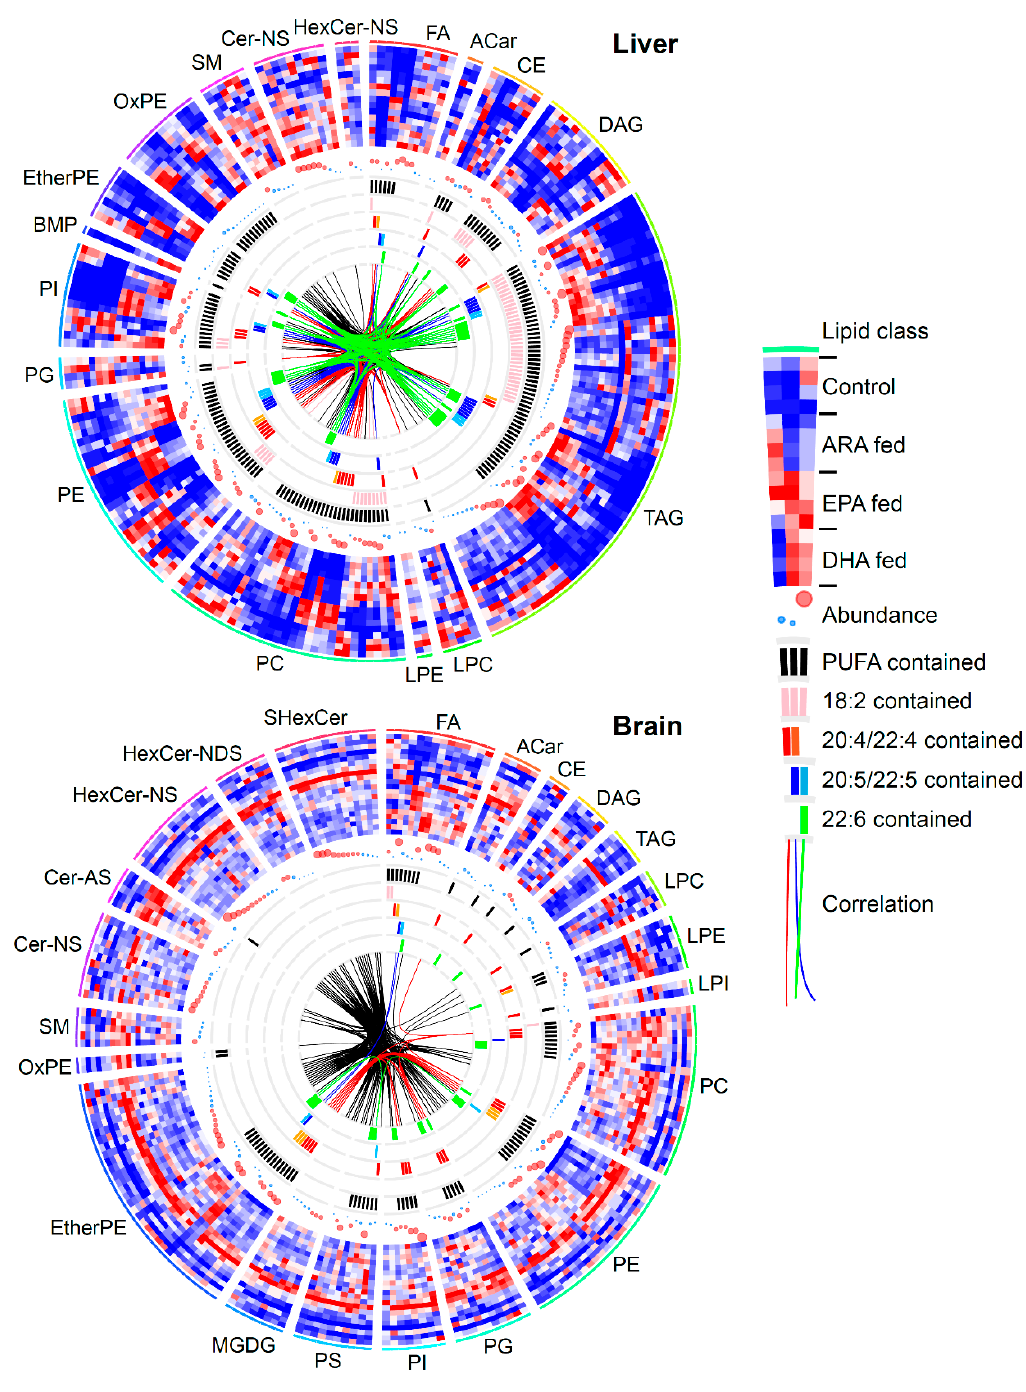
Figure 4. Lipid profiles in the liver and brain from the untargeted lipidomics data. In the circus plot, the lipid profiles are described separately by lipid class. The profile has been scaled in each metabolite from − 1 to 1 in the heatmap. The ion abundance of each lipid is described by the circle size, where the average value in all conditions was utilized for the ion abundance size. Any lipid with more than two double bonds in an acyl chain was defined as a PUFA-containing metabolite. Lipids containing 18:2, 20:4, 22:4, 20:5, 22:5, and 22:6 are marked by pink, red, orange, blue, sky blue, and green colors, respectively. Metabolites were linked if the ion abundance correlation of two metabolites in biological samples was greater than 0.9.